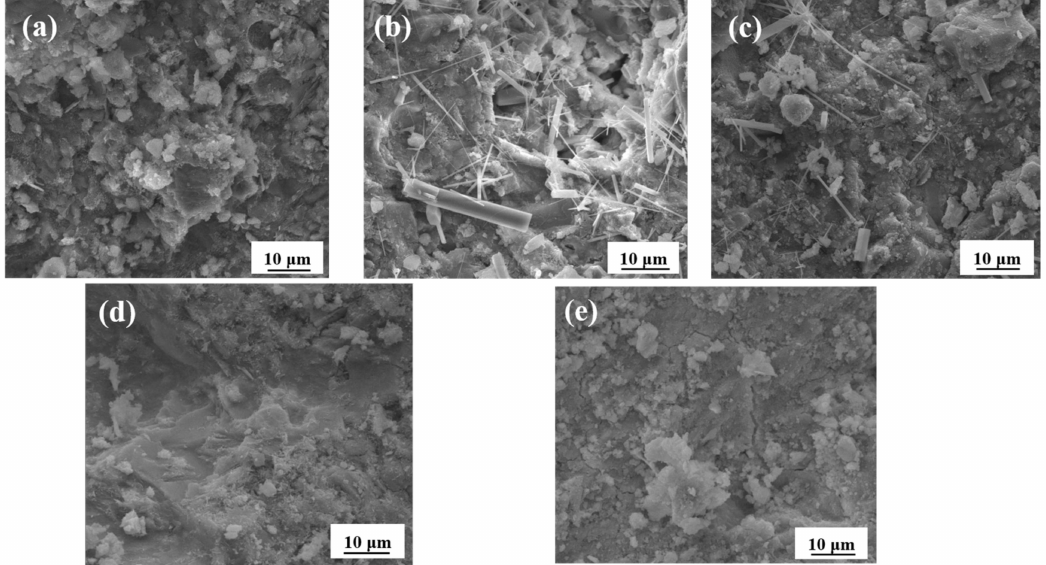
Figure 11. SEM image of treated PP fiber with different dosage after 150 sulfate dry-wet cycles: ( a ) 0%; ( b ) 0.6%; ( c ) 0.9%; ( d ) 1.2%; ( e ) 1.5%.